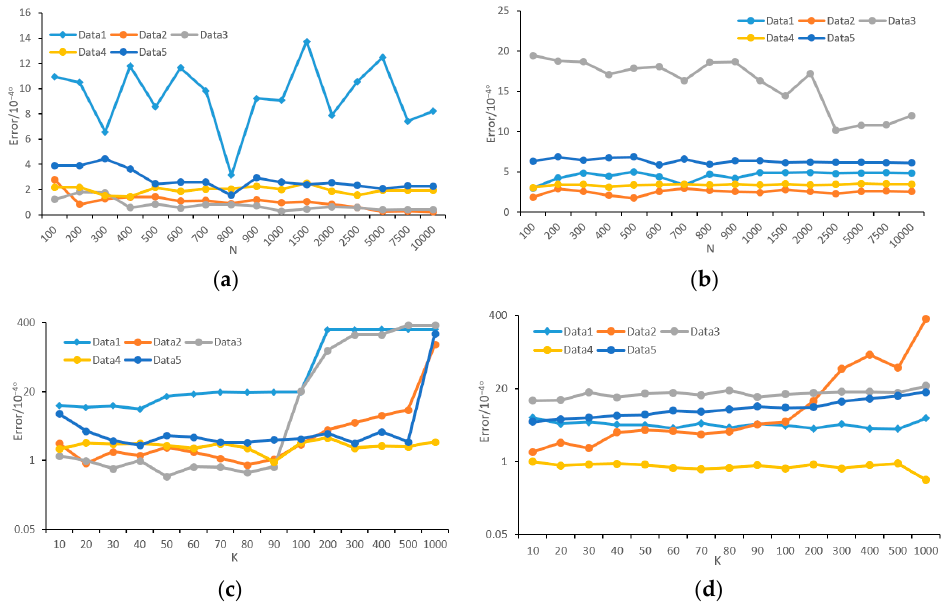
Figure 10. Estimation error with different parameter settings. ( a ) error of horizontal angular resolu- tion with N , ( b ) error of vertical angular resolution with N , ( c ) error of horizontal angular resolution with K , ( d ) error of vertical angular resolution with K .